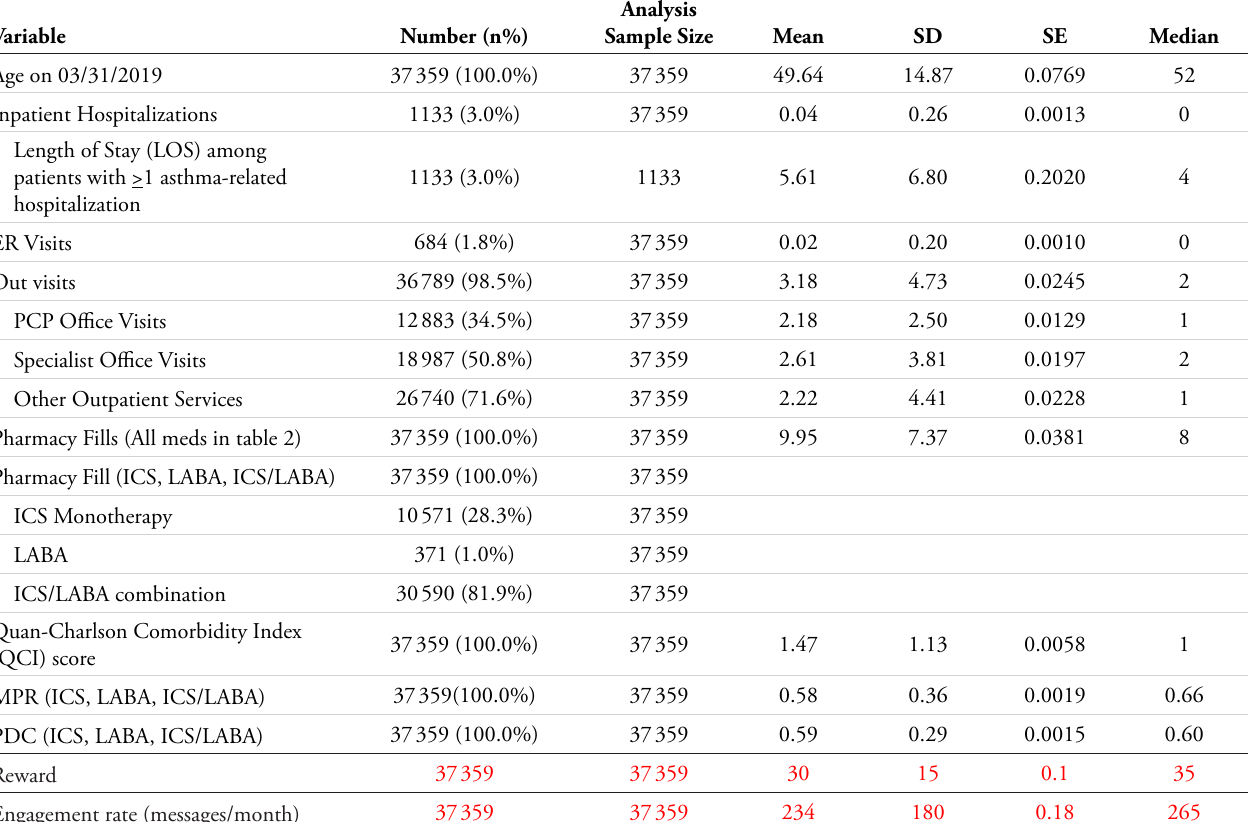
Table 2. Means and Medians for HIRD Data and Two Lateralization Variables, Rewards, and Engagement Rate Derived from